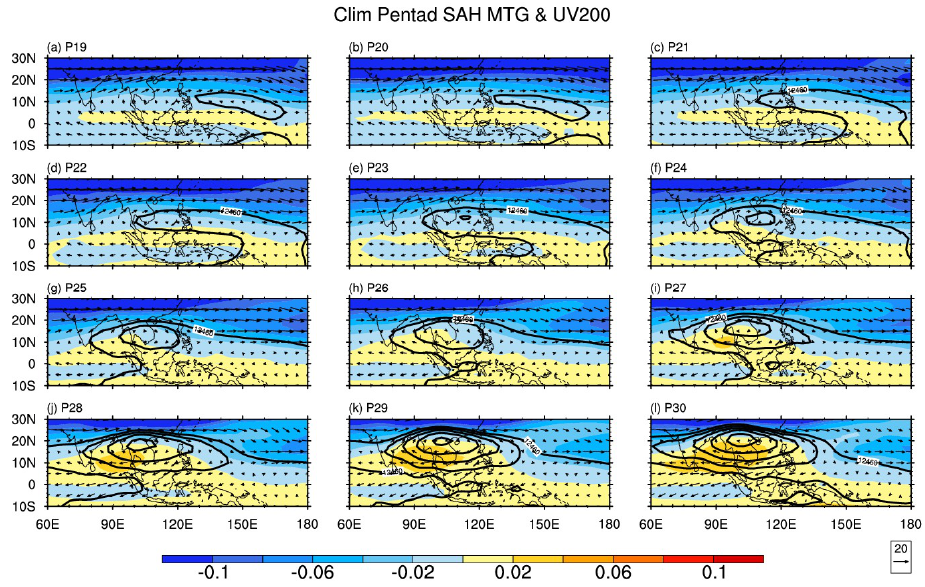
Figure 2. Climatological evolution of the SAH (contours of 12,460, 12,470, 12,480, 12,490, and 12,500 gpm), MTG (shading; K) and horizontal winds (vectors; m / s) at 200 hPa from Pentad 19 to Pentad 30 ( a – l ).